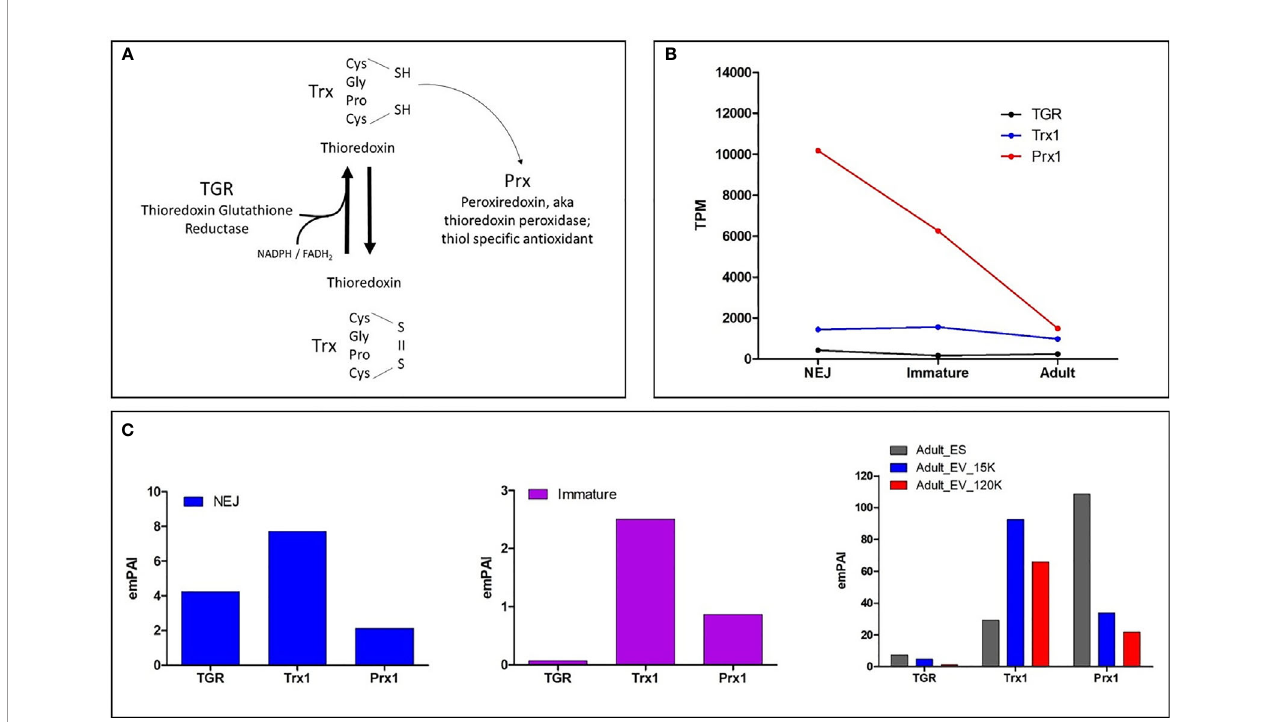
FIGURE 1 | (A) Schematic of the generalised model of the thiol-dependent antioxidant cascade. TGR with the assistance of FADH 2 and NADPH converts oxidised Trx to reduced Trx which subsequently reduces Prx to its activated form. (B) Graphical representation of the most abundantly transcribed genes of the three enzymes in the F. hepatica thiol-dependent antioxidant cascade by the newly excysted juveniles (NEJ) that traverse the small intestinal wall, the liver stage immature parasites 21 days post infection (Immature) and the mature adult stage parasite that resides within the bile ducts (Adult). Data is displayed as transcripts per million (TPM) and is extrapolated from the transcriptome study by Cwiklinski et al. (2015). (C) Graphical representation of the protein abundance within the NEJ, Immature and Adult parasite secretomes (ES proteins), represented by Exponentially Modi fi ed Protein Abundance Index (emPAI). The Adult secretome data shows the protein abundance within the extracellular vesicles, speci fi cally the microvesicles recovered following centrifugation at 15, 000 x g (Adult_EV_15K) and the exosomes isolated after centrifugation at 120, 000 x g (Adult_EV_120K), in addition to the EV-depleted ES proteins. The proteomic data for NEJ, immature and adult parasites is extrapolated from Cwiklinski et al. (2018), Cwiklinski et al. (2021) and Murphy et al. (2020),